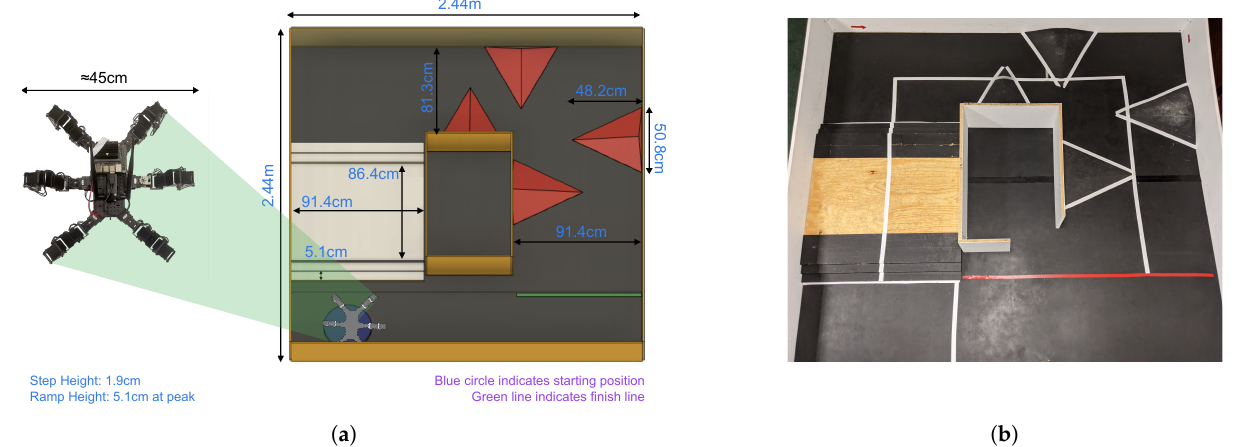
Figure 10. Obstacle course for Experiment II ( a ) CAD rendering with dimensions and ( b ) physical realization. The goal is to start from the bottom left corner and navigate clockwise to the bottom